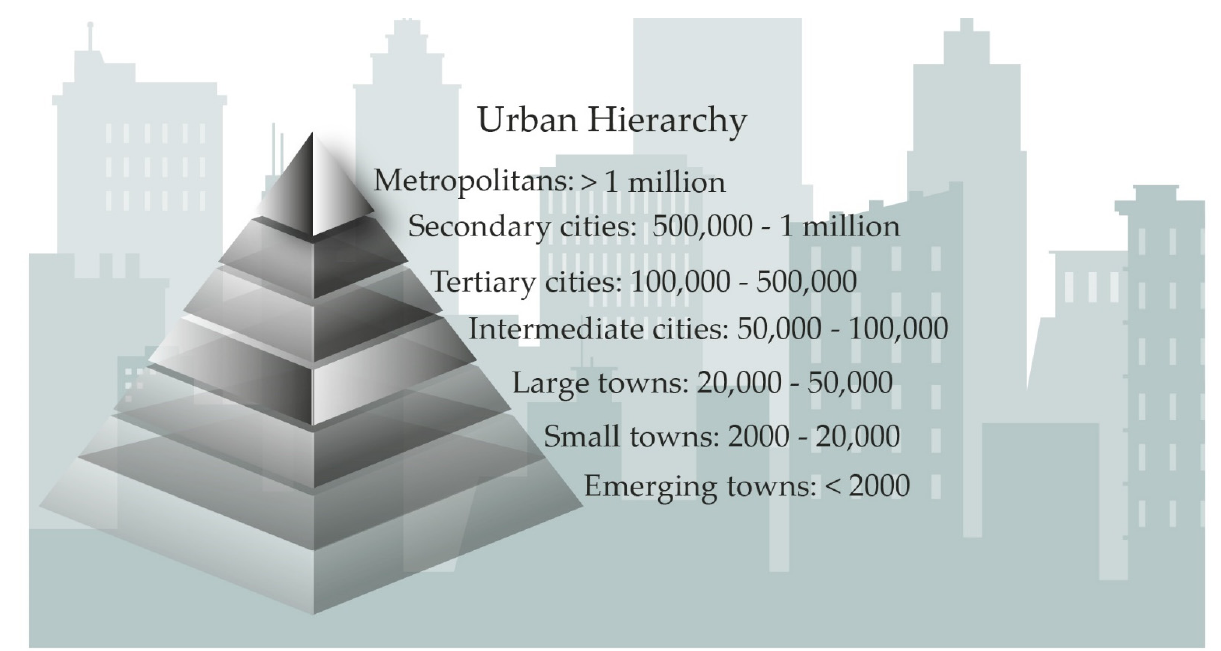
Figure 5. Hierarchy of urban centers in Ethiopia; Source: [48] Computed by authors. Based on this MOUDC [49] population size classification, the existing functional IPDC-owned IPs can be labeled as follows: the Bole Lemi, Kilinto, and Hawassa IPs are intermediate cities; the ICT park is a tertiary city; the Mekele, Adama, and Dire Dawa IPs are large towns; and the remaining IPs are small towns. (See Table 4). Table 4. Potential IPs-based cluster cities with urban hierarchy.